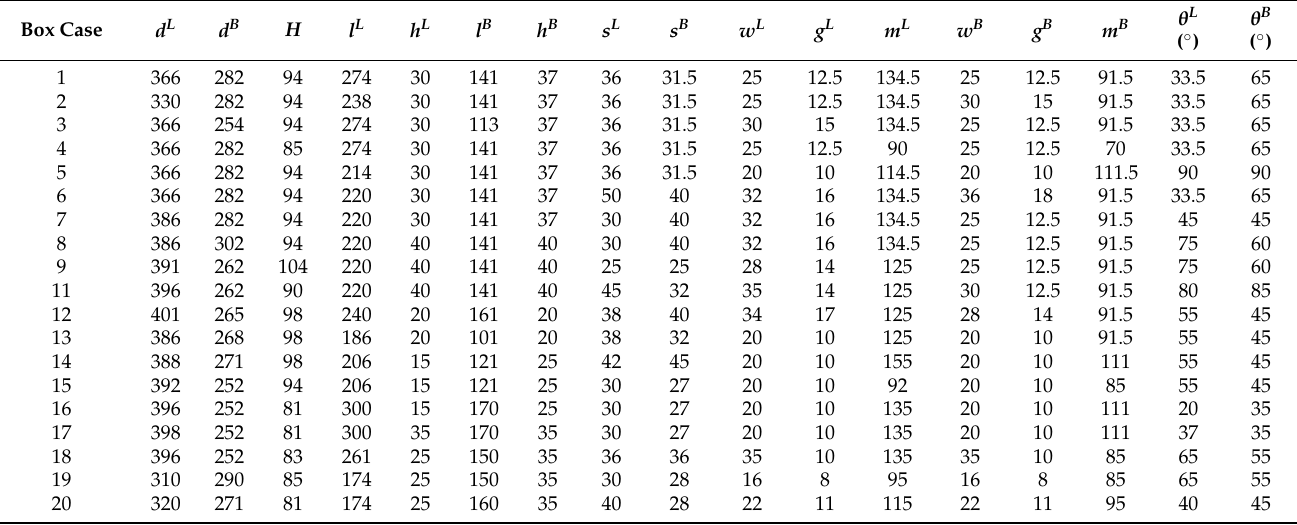
Table 1. Geometric parameters of selected cases of open-top boxes; all dimensions, apart from the last two columns, are shown in